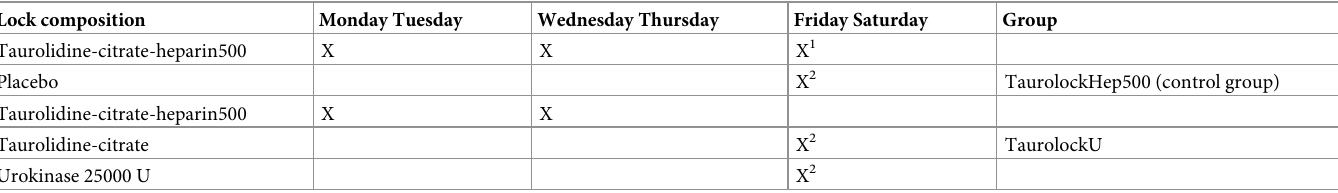
Table 1. Preparation and administration of study